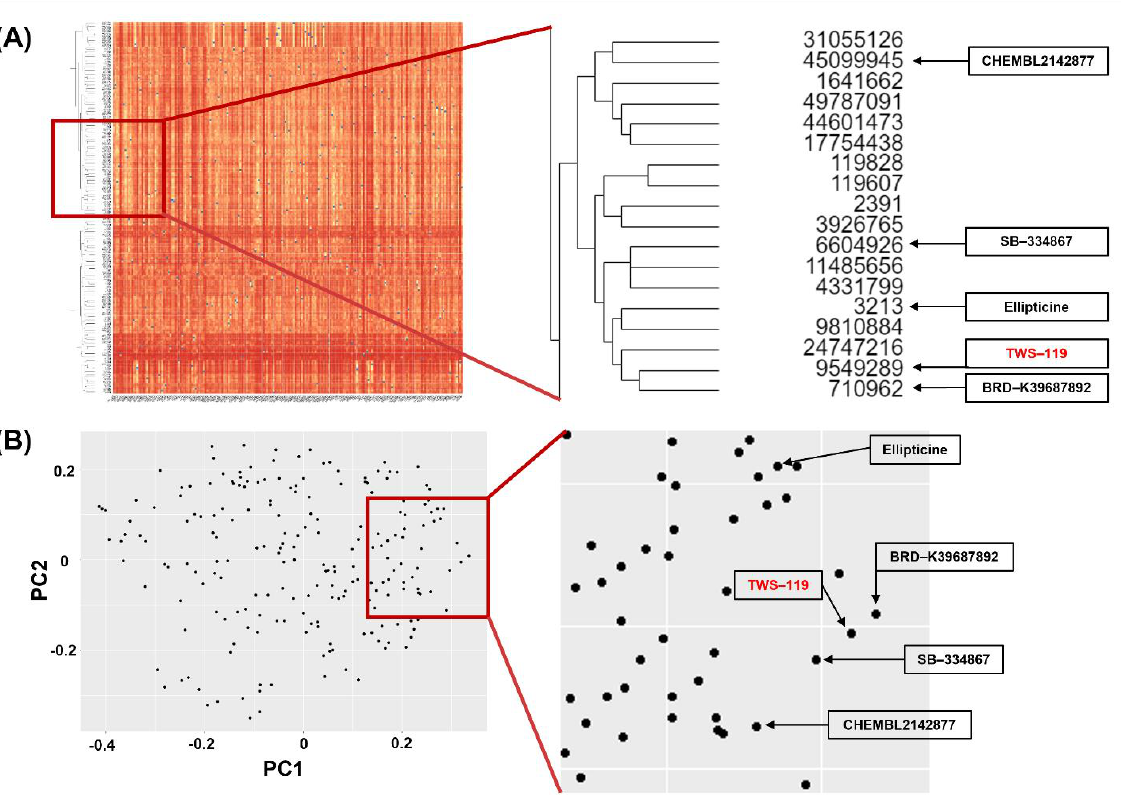
Figure 1. Results of structural similarity; (A) hierarchical clustering and (B) multidimensional clustering. The hierarchical clustering method repeats the process of finding the two most similar structures, then aggregating into the same cluster until all rows are clustered. After the repetition, structurally similar chemicals are arranged together to generate dendrogram. A multidimensional clustering technique is used to visualize high dimensional data into two-dimensional space. This method transforms the coordinate vectors to explain the highest two variances of the dataset. Hierarchical clustering showed that 18 compounds had a similar structure within the respective libraries. Among the 18 compounds, we found that five compounds were overlapped in multidimensional clustering analysis.